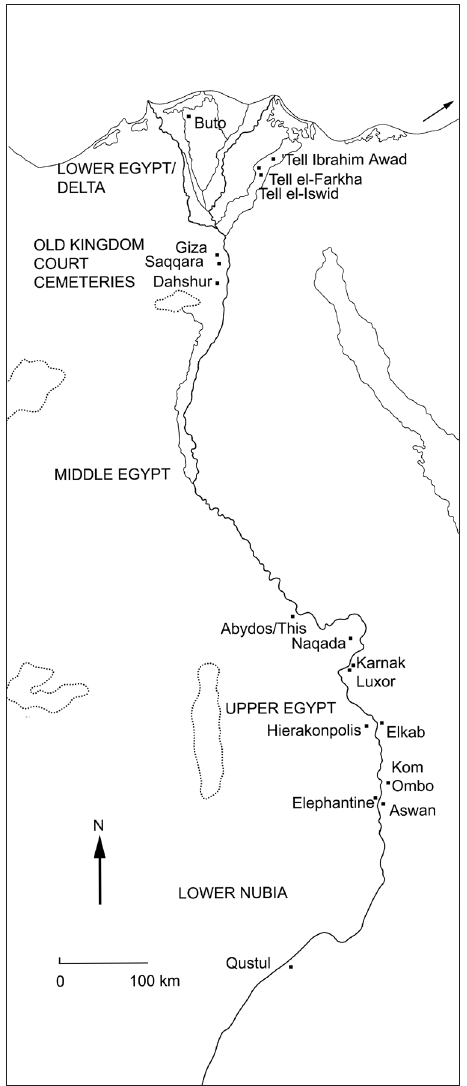
Fig. 2: Map of Egypt with sites mentioned in the text. (Compiled by R.